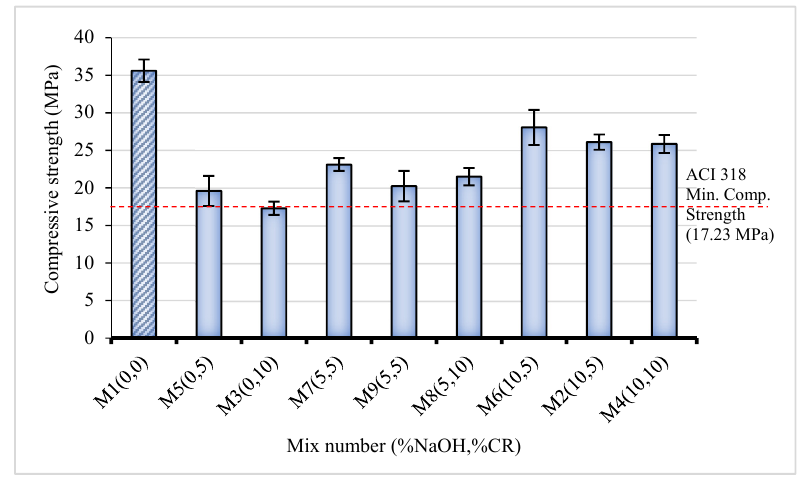
Figure 5. Compressive strength of NaOH-CRC mixes at 28 days.